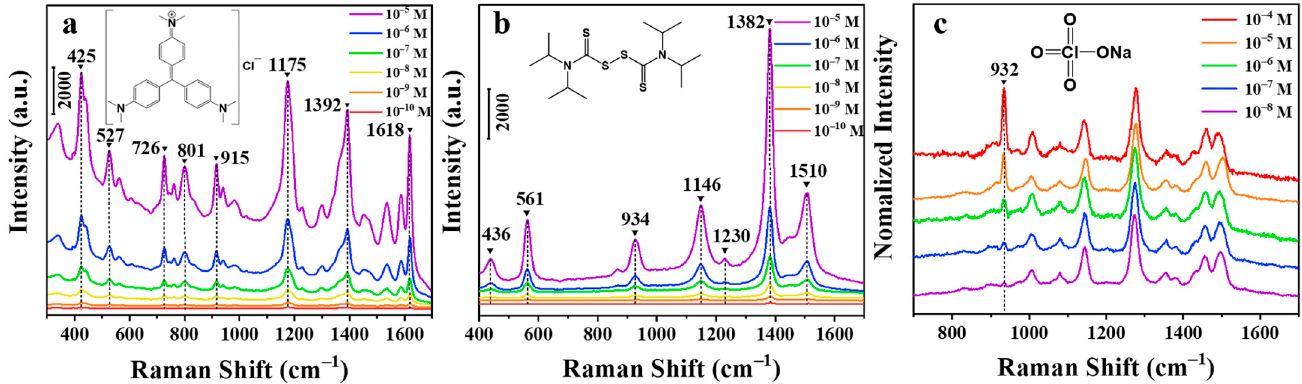
Figure 6. SERS spectra of crystal violet ( a ), thiram ( b ), and sodium perchlorate ( c ) on silver nanowire membranes treated by 15 CV cycles at 20 °C.